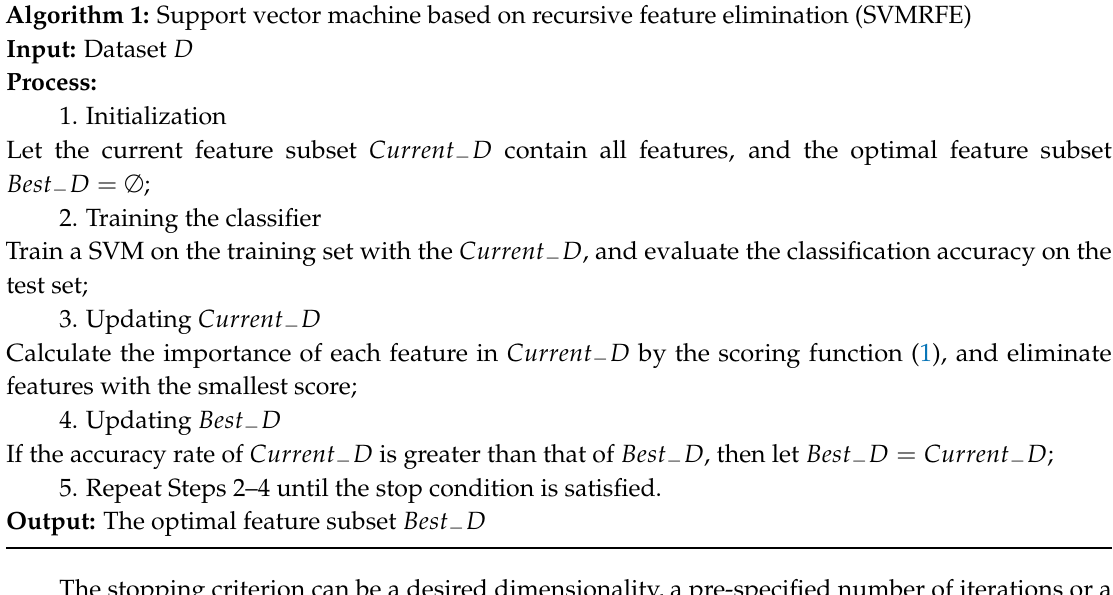
Algorithm 1: Support vector machine based on recursive feature elimination